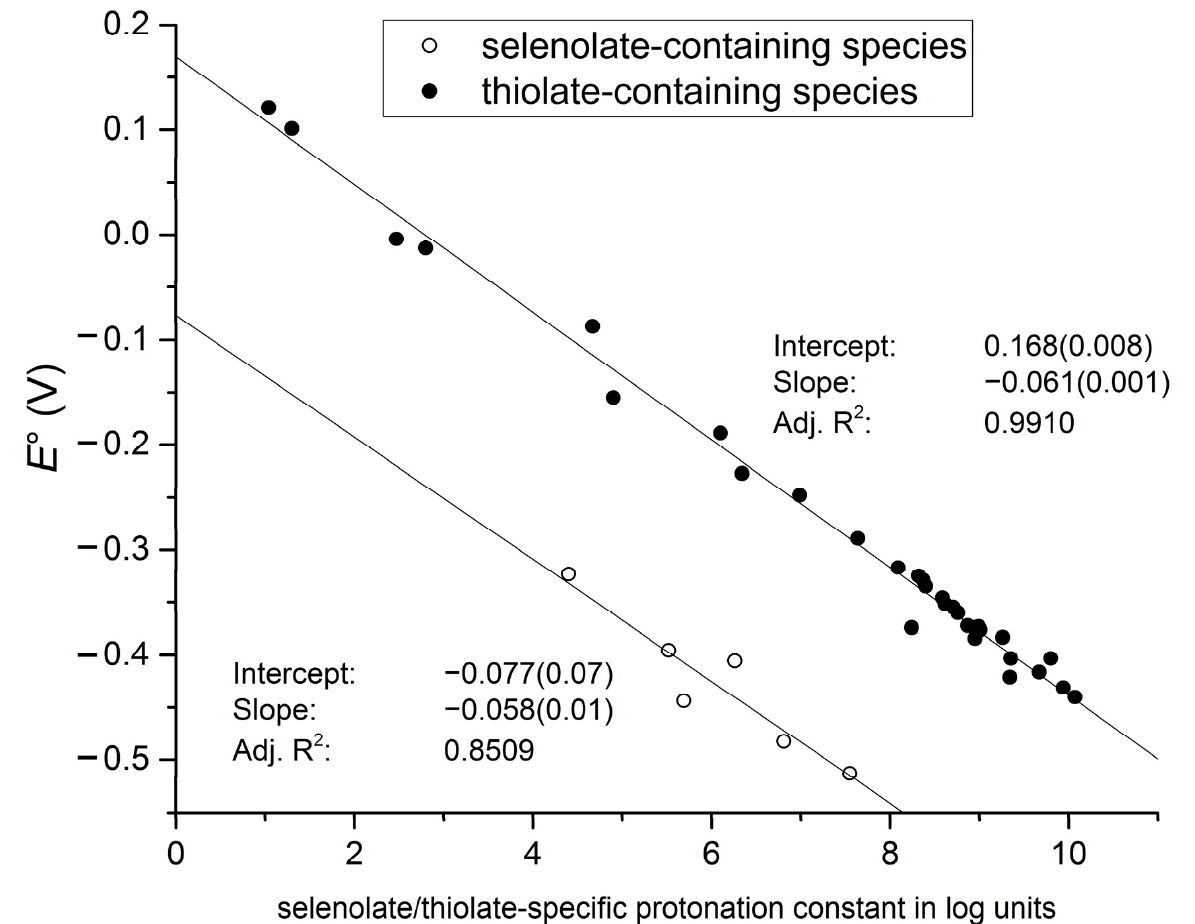
Figure 9. Correlation between standard redox potentials and species-specific thiolate protonation constants for various thiol-containing compounds (glutathione, cysteine, cysteamine, homocysteine, penicillamine, ovothiol A, DTT); the correlation between standard redox potentials and the species-specific selenolate protonation constants for various selenol-containing compounds (lower line, empty circles). Reproduced from [49].